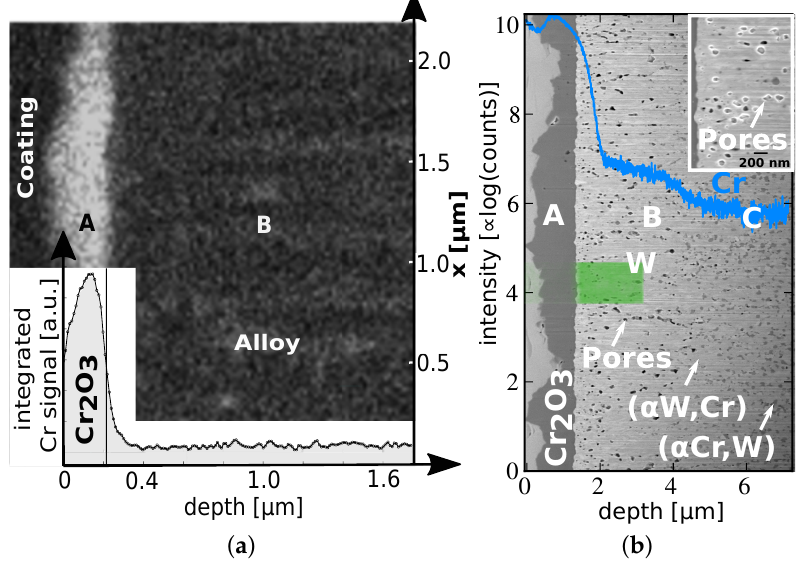
Figure 6. ( a ) Map of the chromium concentration measured with EDX on the W-12Cr-0.5Y sample shown in Figure 4b. The intensity signal was based on the Cr L α 1,2 lines. The inset is derived by integration of the intensity over x. The regions of the oxide and the alloy are labeled A and B, respectively; ( b ) Electron microscopy image of a cross section of a thick (7.6µm) W-13Cr-1Y alloy. It was exposed to a temperature of 1273K at 20kPa O 2 and 80kPa Ar partial pressure for 6h. Overlayed are the corresponding Cr-profile measured using SIMS and an EDX map of W based on the W M α line. The image in the inset has an increased magnification and shows the pores more